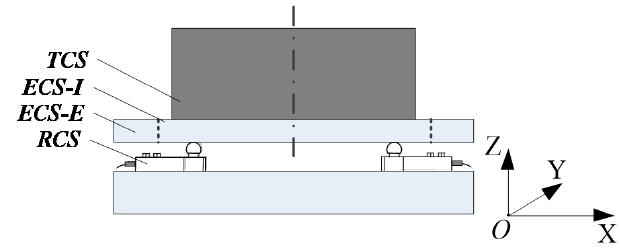
Figure 5. The method of establishing the coordinate